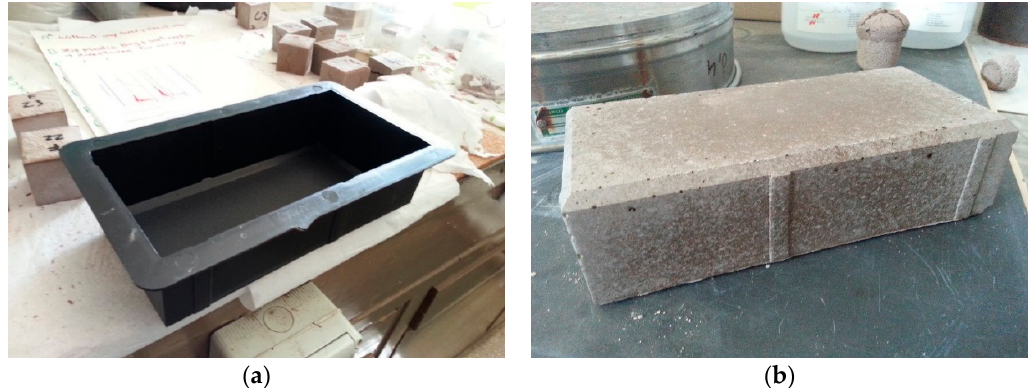
Figure 2. ( a ) Plastic mold; ( b ) Final paving blocks after de-molding.